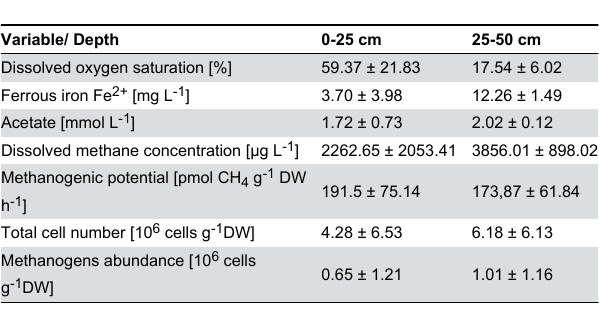
Table 2. Vertical gradient of physico-chemical parameters and variables of the hyporheic interstitial water and sediment at the locality no. IV (average ±